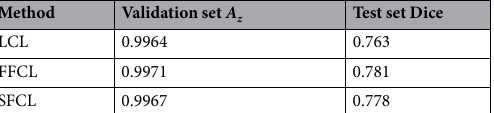
Table 5. A performance comparison of the single-scale architecture with different possible locations to add the spatial location information. Abbreviations: last convolutional layer (LCL), first fully connected layer (FFCL), second fully connected layer (SFCL).